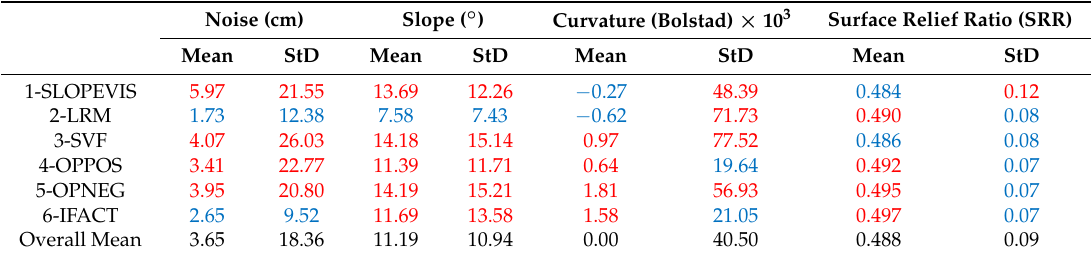
Table 4. Highest Gradient Model zonal statistics for the panel of visualizations selected. Mean noise is computed as the StD of the StD layer. Mean curvature (Bolstad variant) is multiplied by 10 3 ; Surface Relief Ratio value is given as 0–1 value. Values under and above the overall mean are highlighted in blue and red, respectively. Curvature and SRR values have dimensionless units. Noise (cm) Slope ( ◦ ) Curvature (Bolstad) × 10 3 Surface Relief Ratio